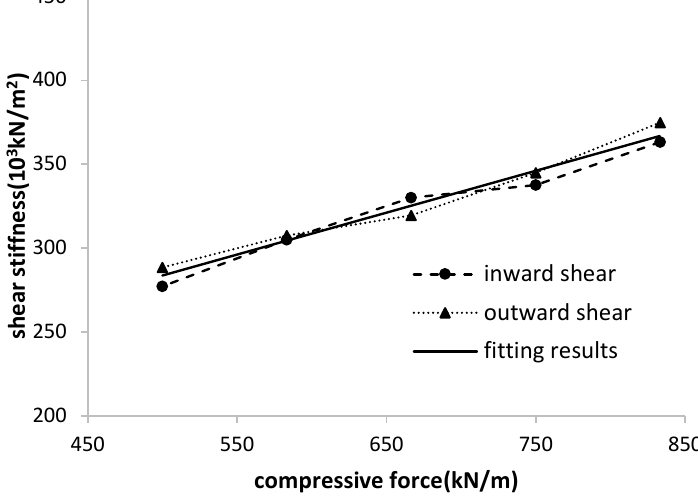
Figure 9. Relationship between shear stiffness and compressive force.